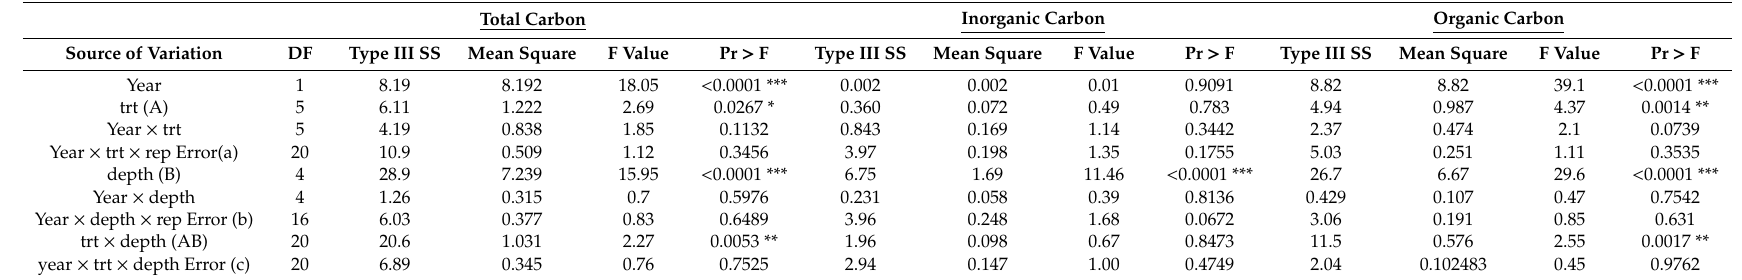
Table 1. Sources of variation, degrees of freedom, mean squares, and results of F-tests from the combined analyses across years for total carbon (STC), inorganic carbon (SIC), and organic carbon